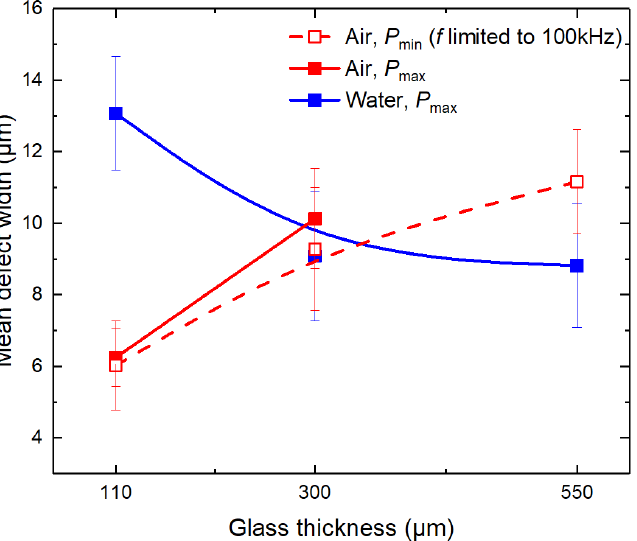
Figure 7. Mean defect widths at the cut edge at the back side of laser-cut glass strips. Dots are connected to guide the eye. Error bars indicate the standard deviation.